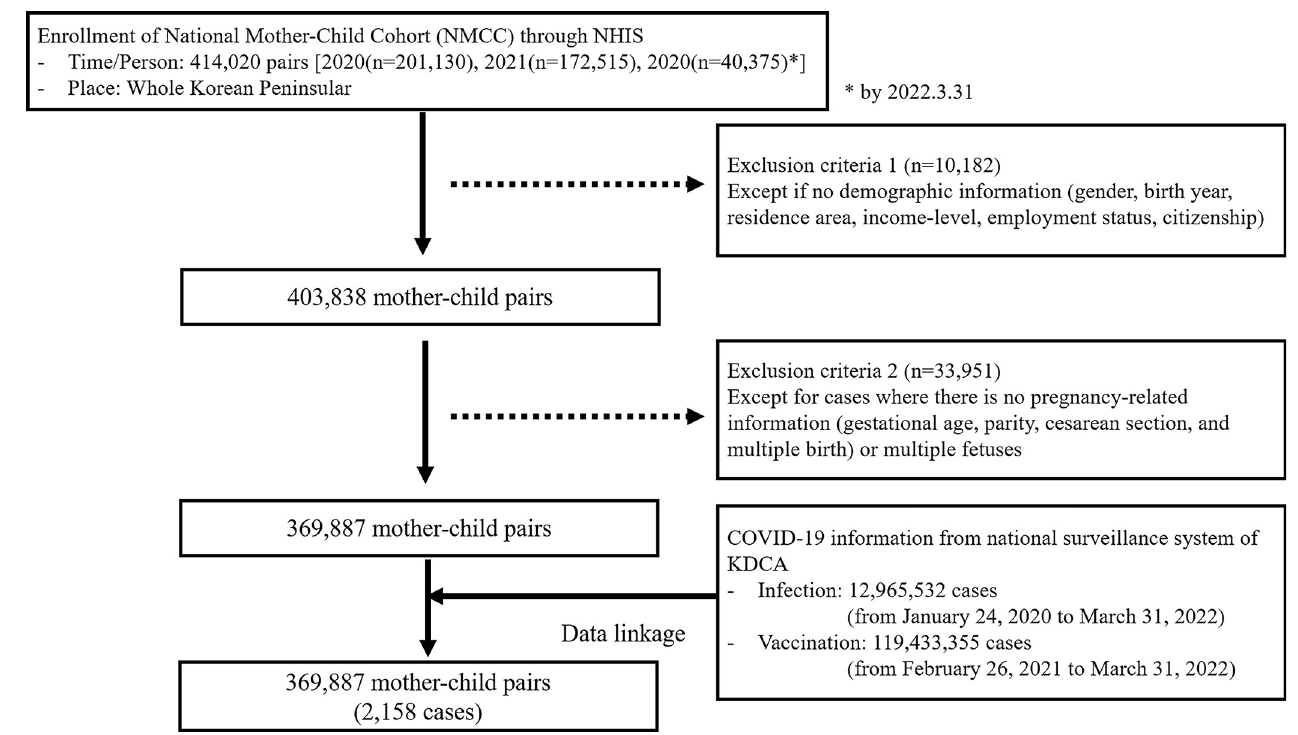
Fig 1. Enrollment of National Mother-Child Cohort (NMCC) for the association of COVID-19 infection during pregnancy with maternal and neonatal outcomes.